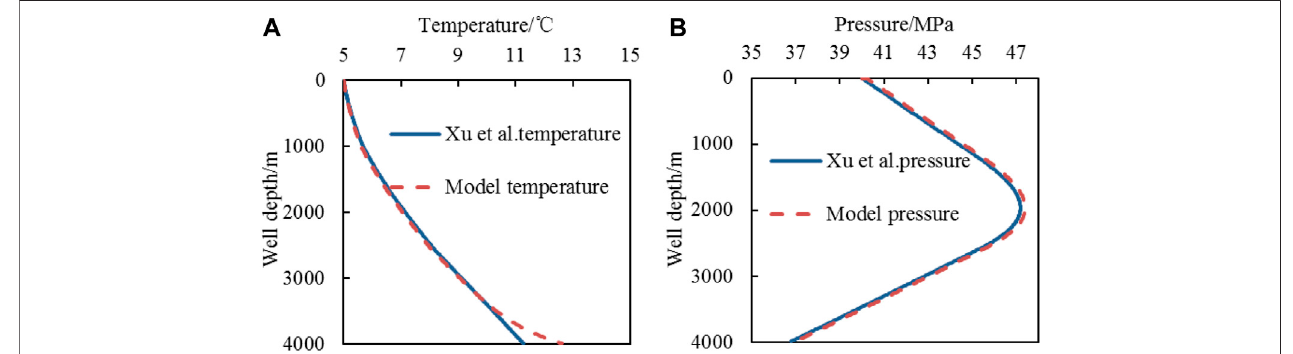
FIGURE 4 | Temperature and pressure distribution of CO 2 foam gas-liquid two phases in the wellbore [ (A) : temperature pro fi le; (B) : pressure pro fi le].